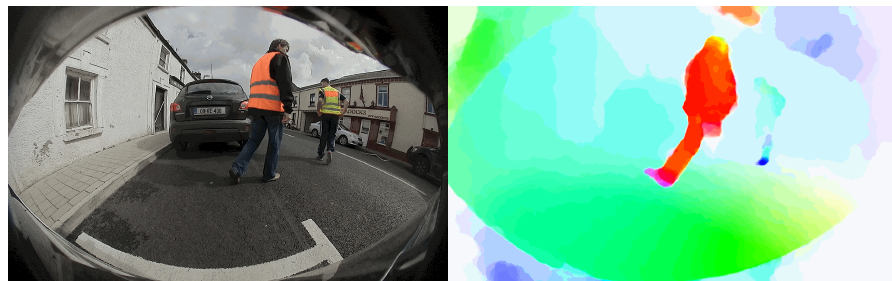
Figure 6. Illustration of geometric deep learning algorithm for computation of dense optical